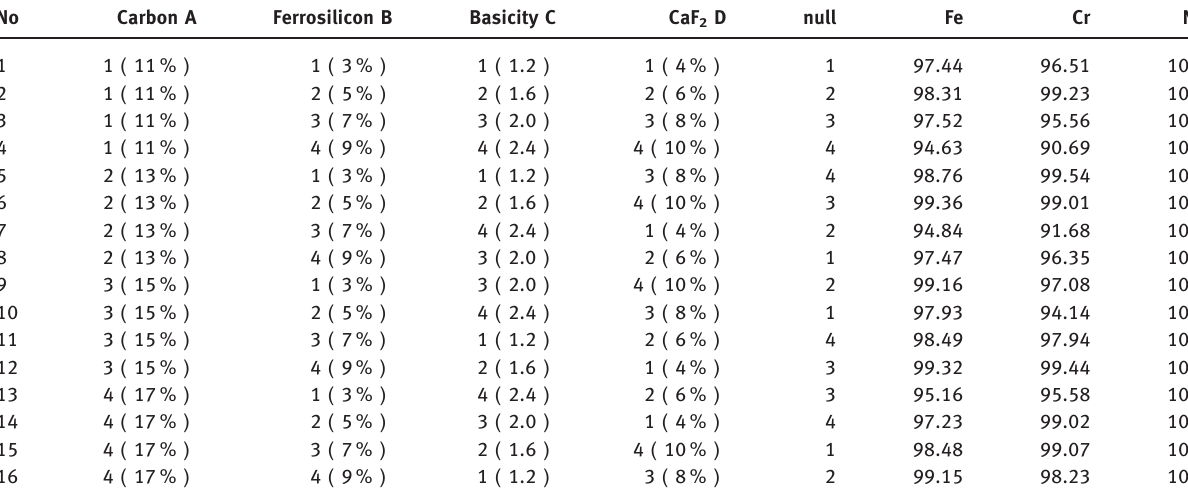
Table 4: Optimization results for SSDB reduction